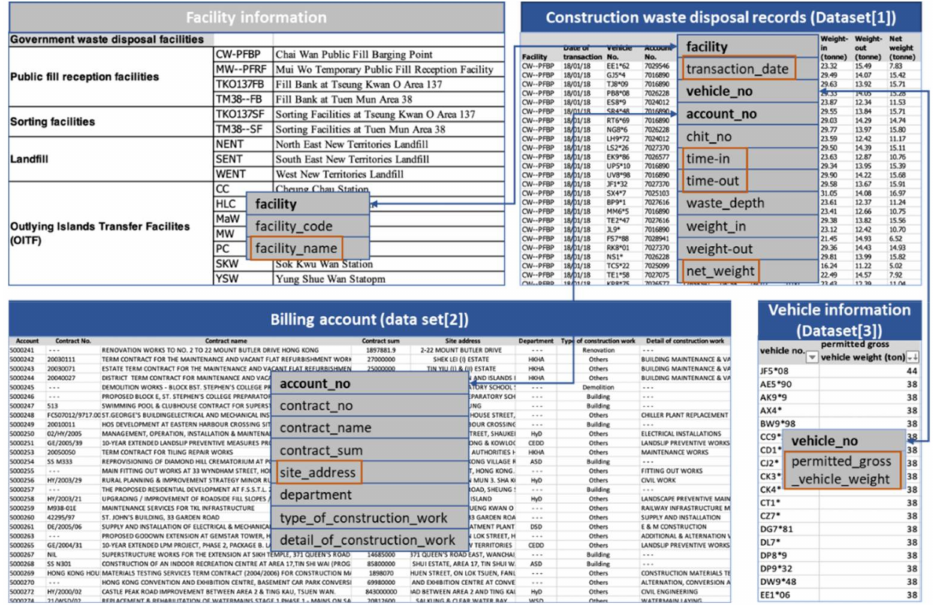
Figure 3. Three datasets and their interdependency. Table 3. Details of construction waste disposal